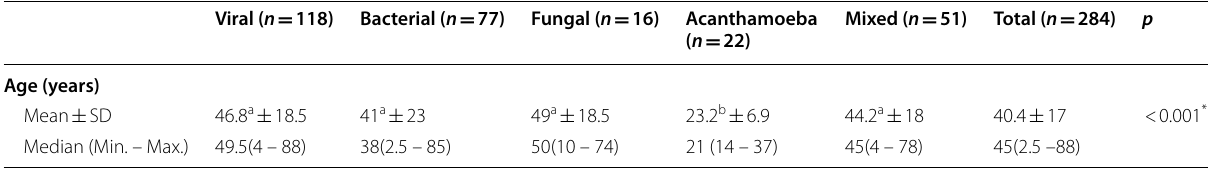
p : p -value for comparing between the studied groups, SD Standard deviation * Statistically significant at p 0.05 Numbers with different letters are significant ≤ Of the 284 patients, 163 cases (57.4%) were males and 121 cases (42.6%) were females. In the acanthamoeba group, all cases were female and this was statistically significant in comparison with the other groups ( p < 0.001) (Fig. 7)